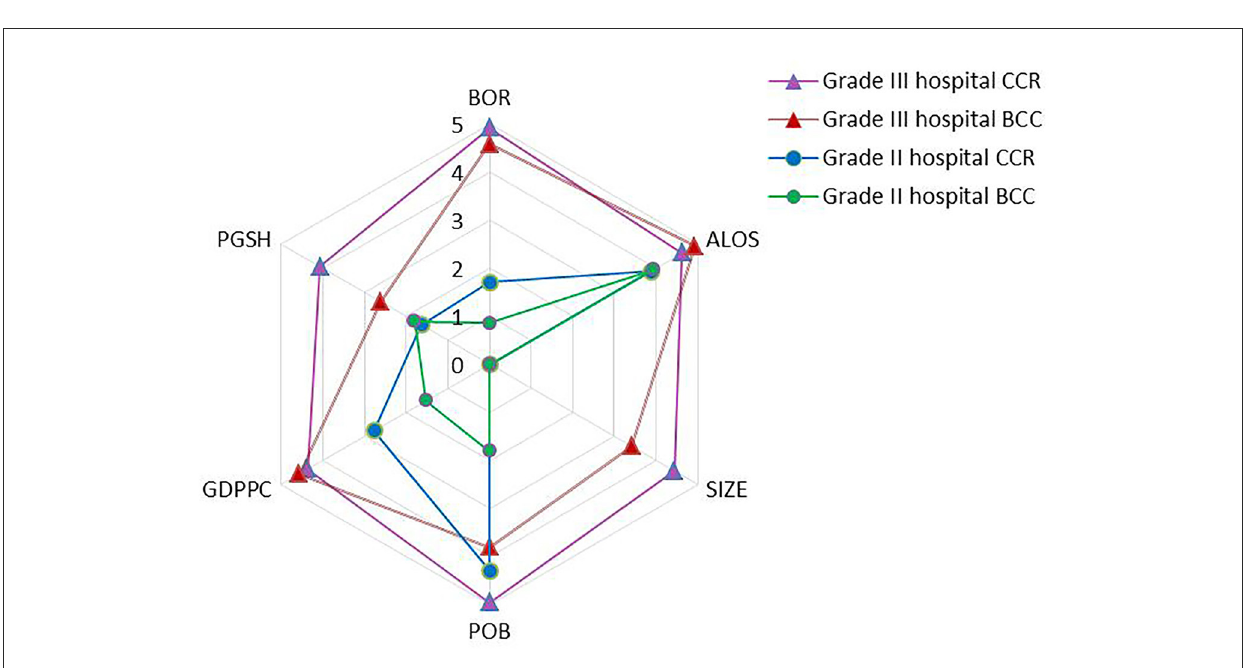
FIGURE4 Comparison of the significance of environmental